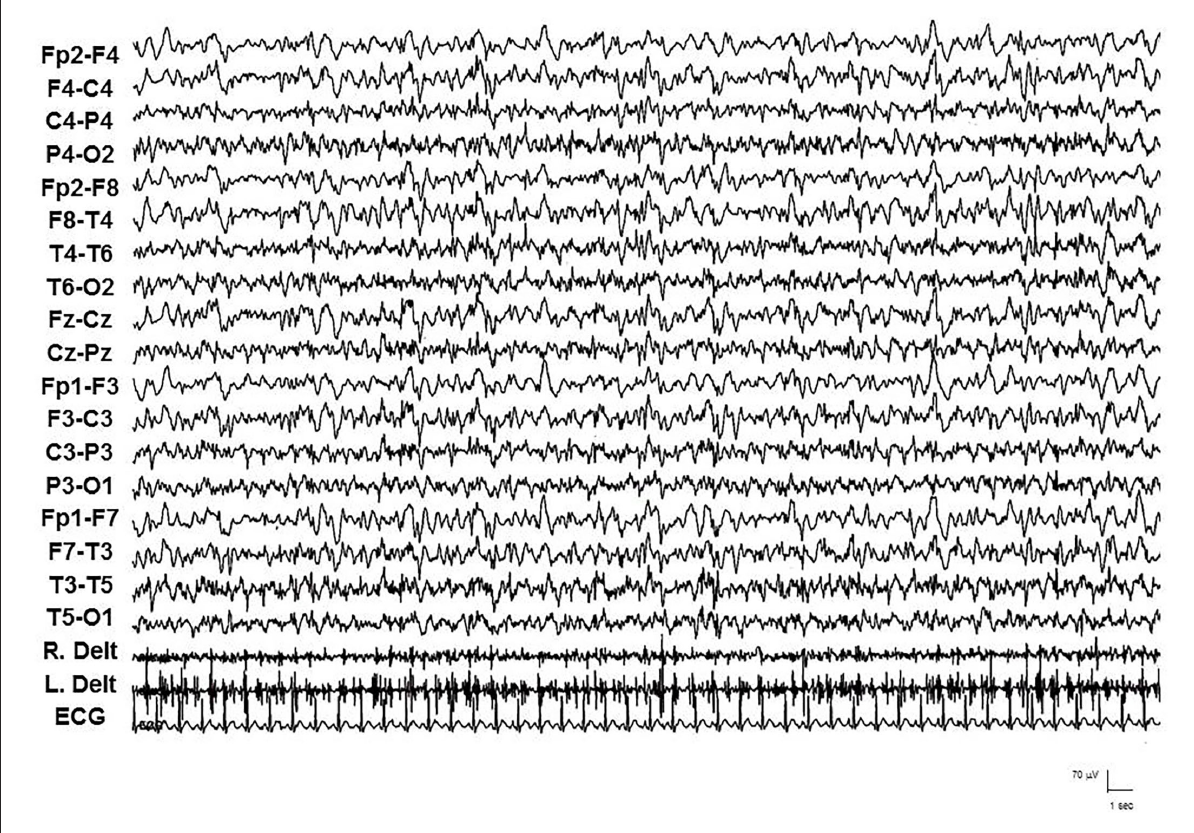
FIGURE3 Video-EEG/polygraphic features of focal motor SE in patient 2 during the late stage, with continuous myoclonic jerks in the left